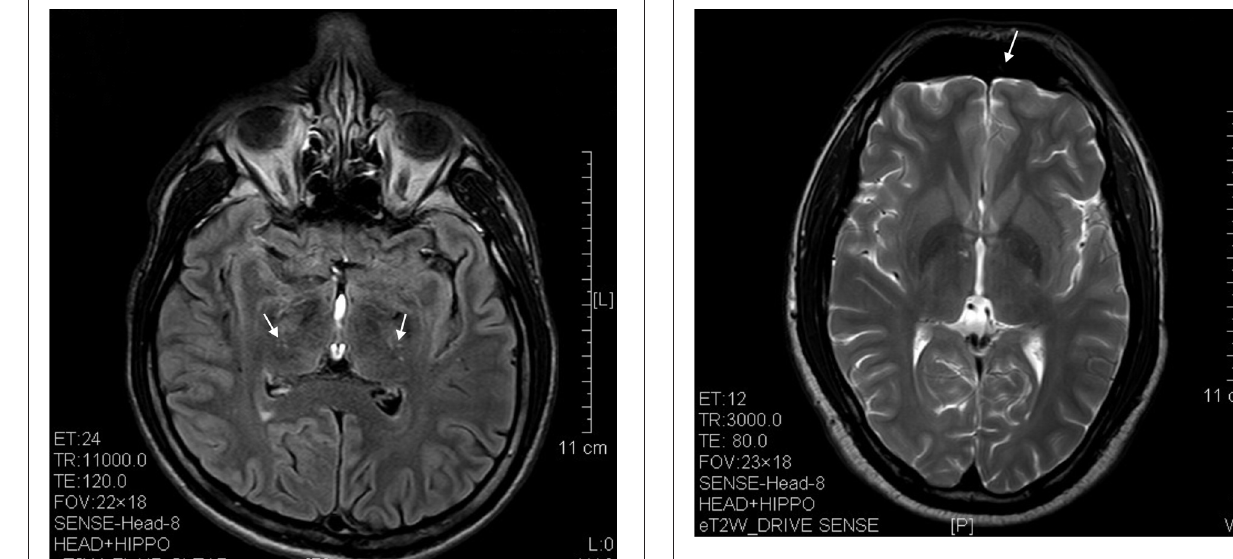
FIGURE 8 | T2 image showed significant prefrontal atrophy (arrow) in a horizontal brain section of a ketamine addict who had high dose of ketamine (3g per day) for only 3 years.